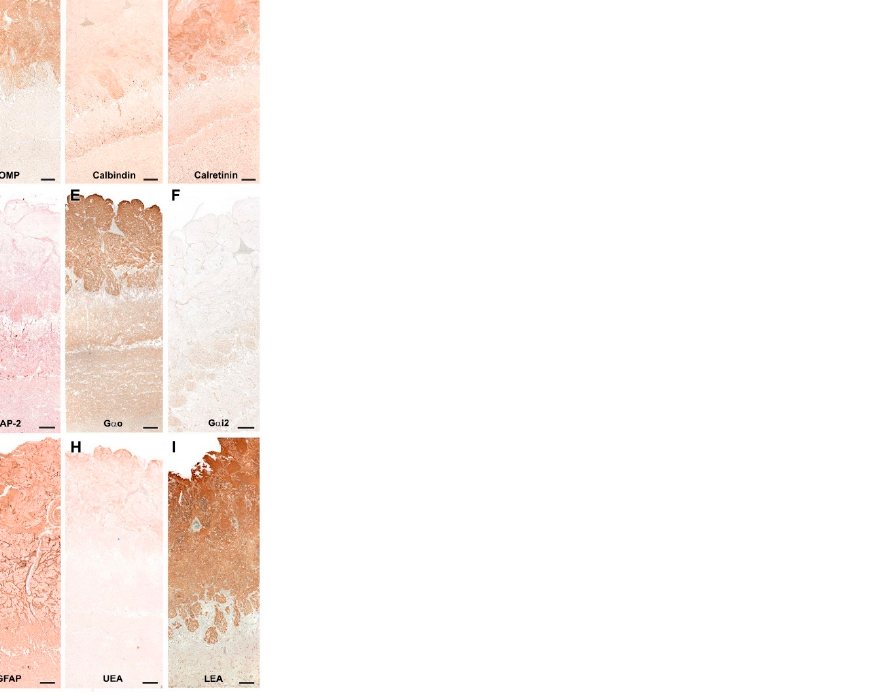
Figure 8. Immunohistochemical and lectin-histochemical study of the OB of the dog. ( A ) Anti-Olfactory marker protein (OMP). ( B ) Anti-Calbindin. ( C ) Anti-Calretinin. ( D ) Anti-MAP-2. ( E ) Anti-Gao. ( F ) Anti-Gai2. ( G ) Anti-GFAP. ( H ) UEA histochemical labeling. ( I ) LEA histochemical labeling. NL, Nerve layer. GIL, Glomerular layer. EPL, External plexiform layer. MCL, Mitral cell layer. IPL, Internal plexiform layer; GrL, Granular layer. Scale bars: 100